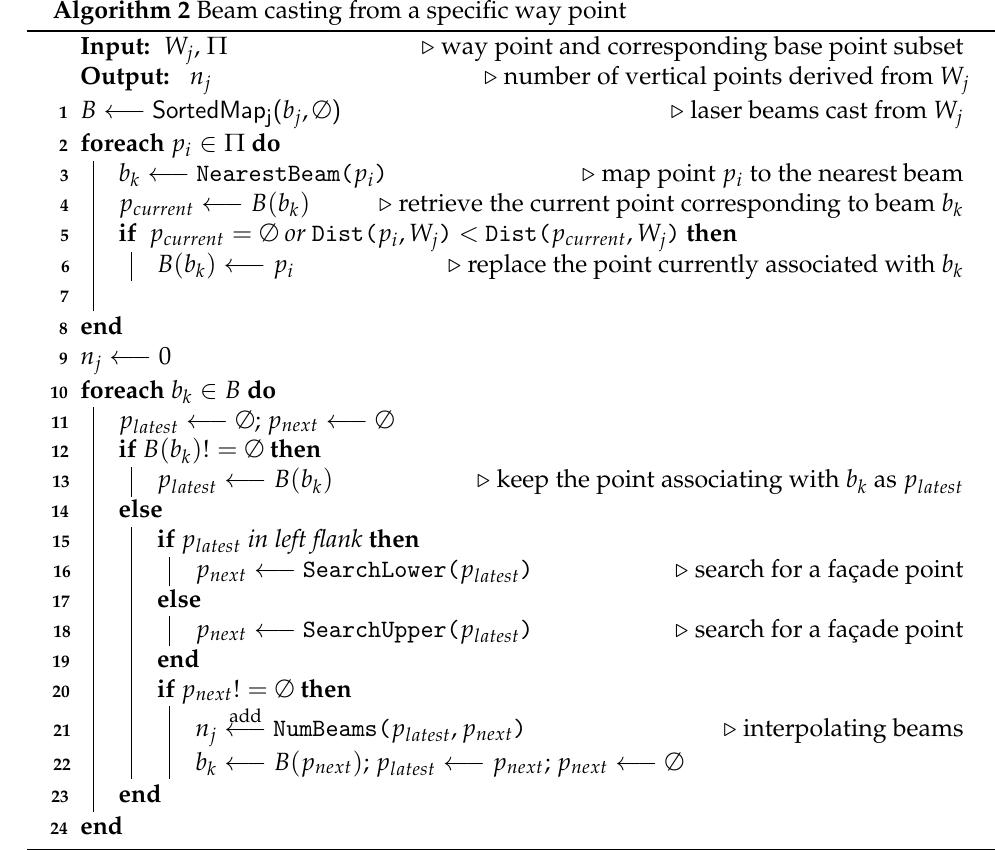
Algorithm 2 Beam casting from a specific way